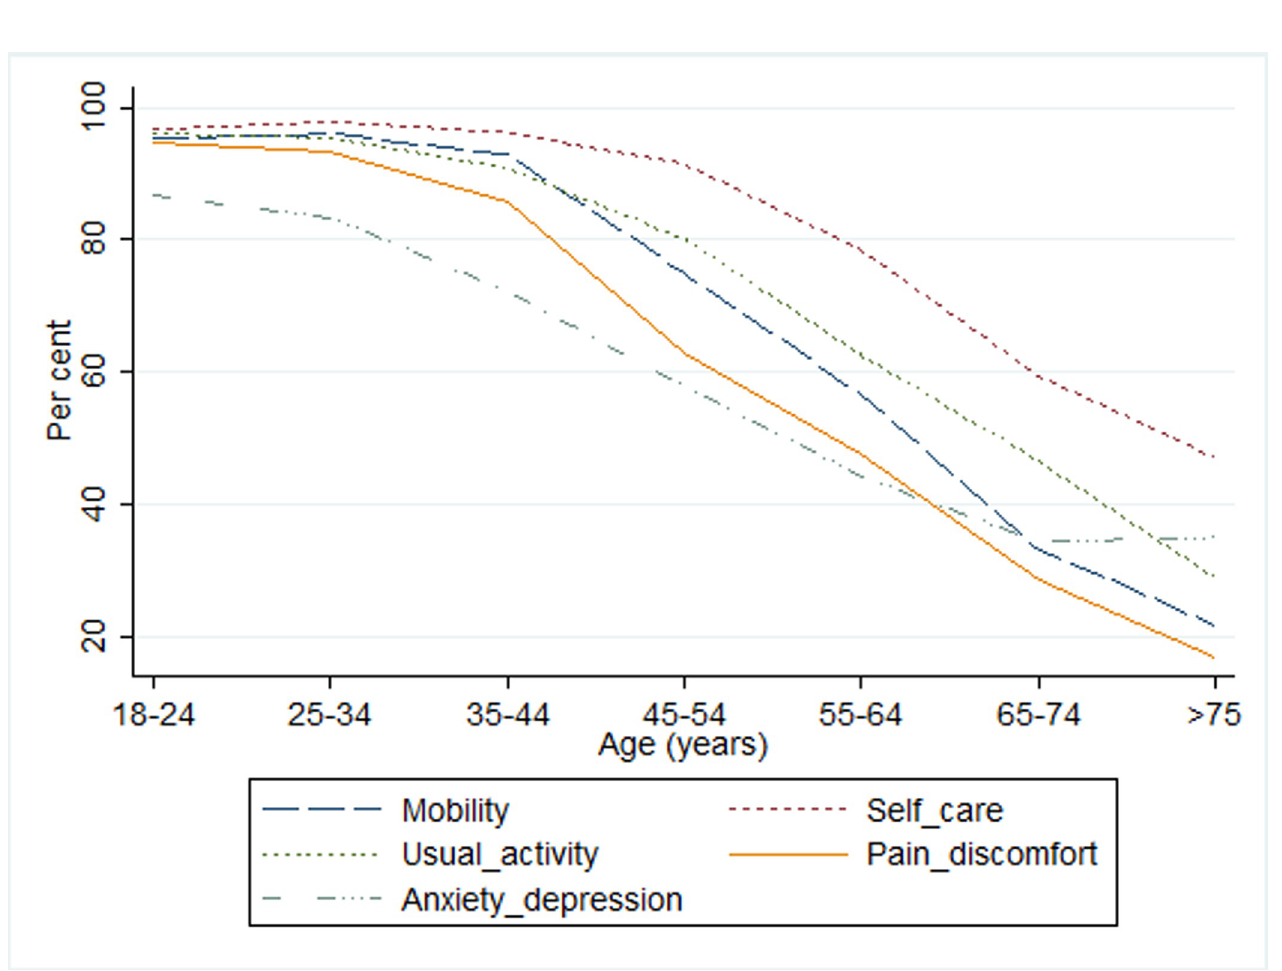
Fig 1. Per cent of respondents reporting level 1 (no problems) in each